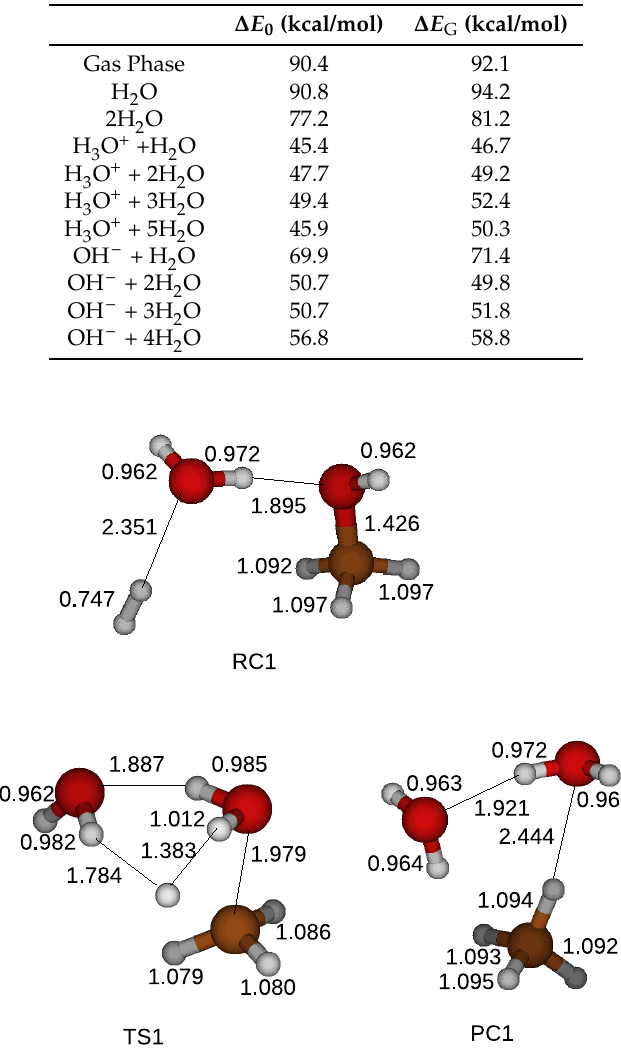
Table 1. The energy barriers, ∆ E 0 , as well as the free energy difference, ∆ E G , between a reactant compound and a transition state at 298.15 K for the reduction of a methanol in the unit of kcal/mol.